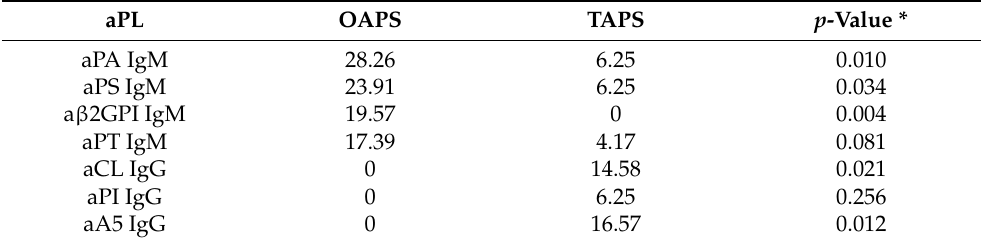
Table 3. Percentage of obstetric antiphospholipid syndrome (OAPS) and thrombotic antiphospho- lipid syndrome (TAPS) patients who tested positive for the indicated antiphospholipid antibody (aPL).